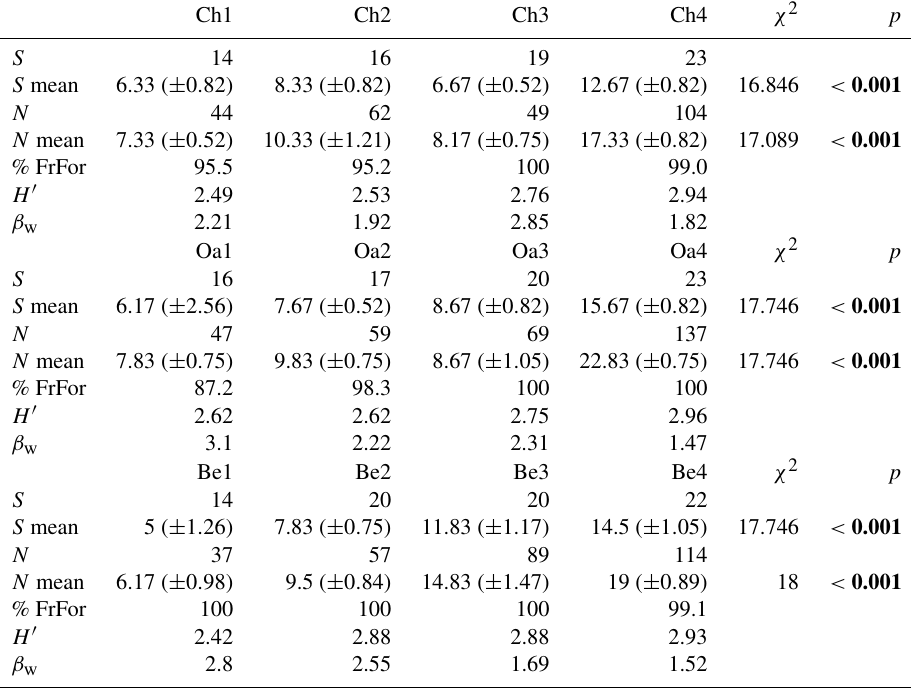
Table 2. Structural parameters of the bird community in the different forest habitats (Ch is chestnut; Oa is Turkey oak; Be is beech woods). S is species richness; S mean is mean species richness (and standard deviation, SD); N is total abundance; N mean is mean abundance (and SD); % FrFor is proportion (in percentage) of forest species frequency; H (cid:48) is Shannon–Wiener diversity index; β w is intra-habitat β diversity. Coefficient ( χ 2 ) of Friedman test and p values are reported. Significant values are in bold.